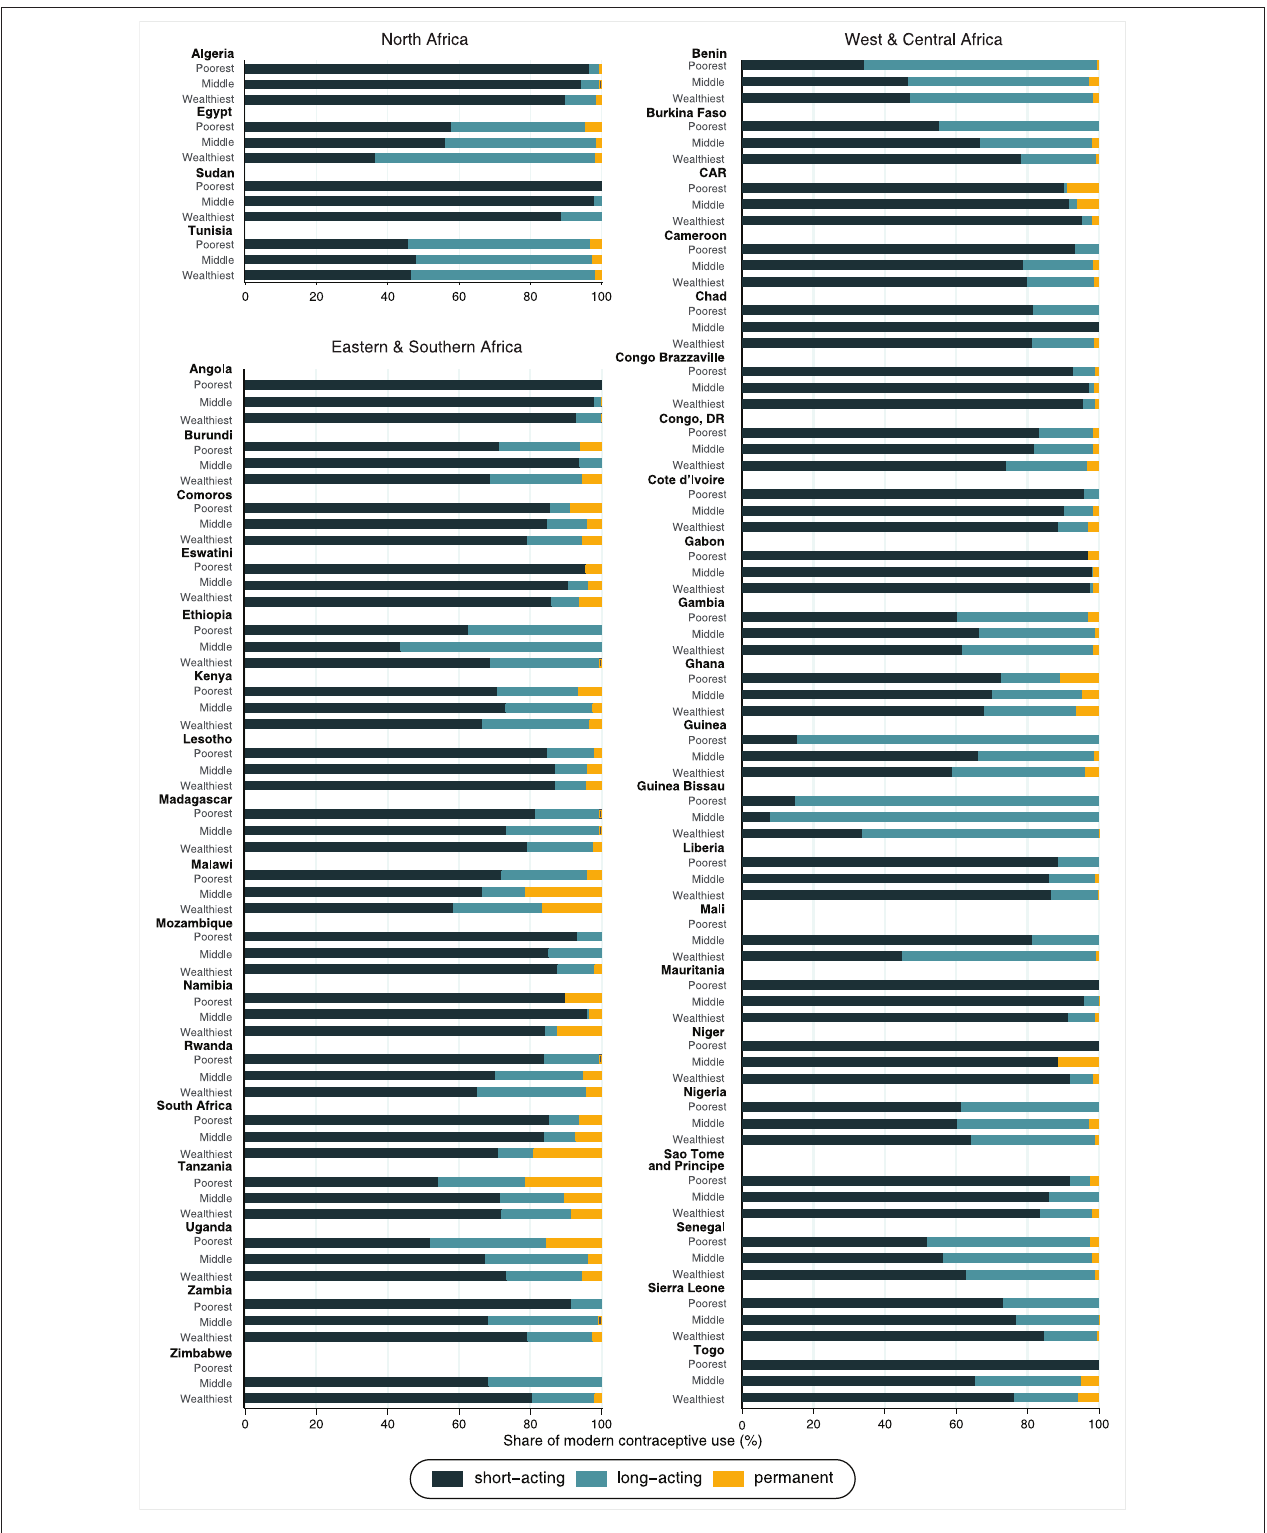
FIGURE 5 | Share of modern contraceptive use according to wealth groups*. *In Mali and Zimbabwe, the bars related to the poorest are not presented because we have no observation on modern contraceptive use among women from the poorest wealth tertile.